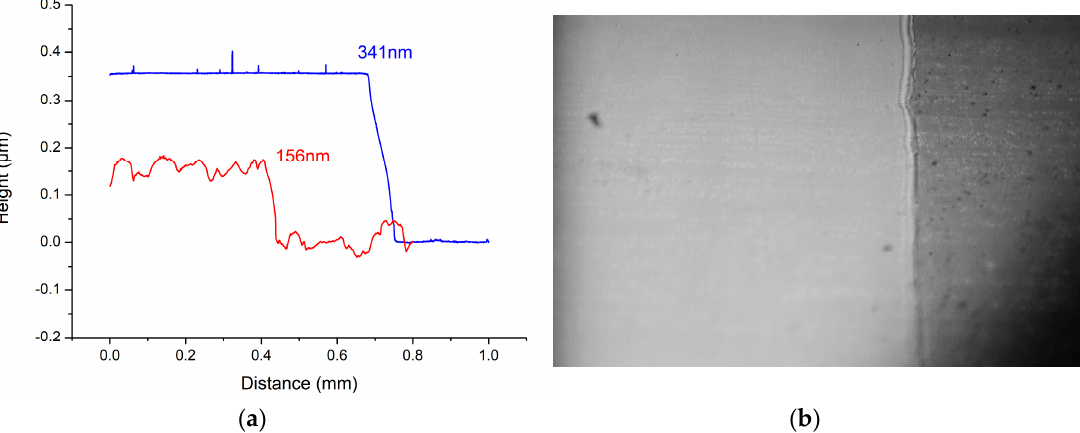
Figure 8. Alpha Step measurements of the Ga 2 O 3 thin film for ( a ) 341 and 156 nm thickness, and ( b ) an optical microscope image of the thin film surface.